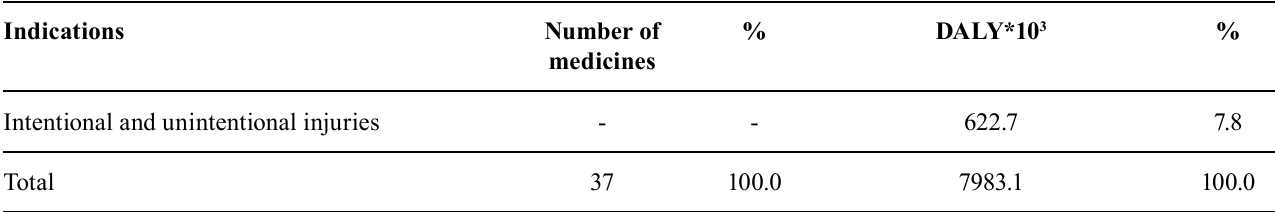
TABLE III – Number of pediatric new drugs registered in Brazil from 2003 to 2013 and number of DALYs of children from 0 to 14 years according to ICD-10 categorization of the